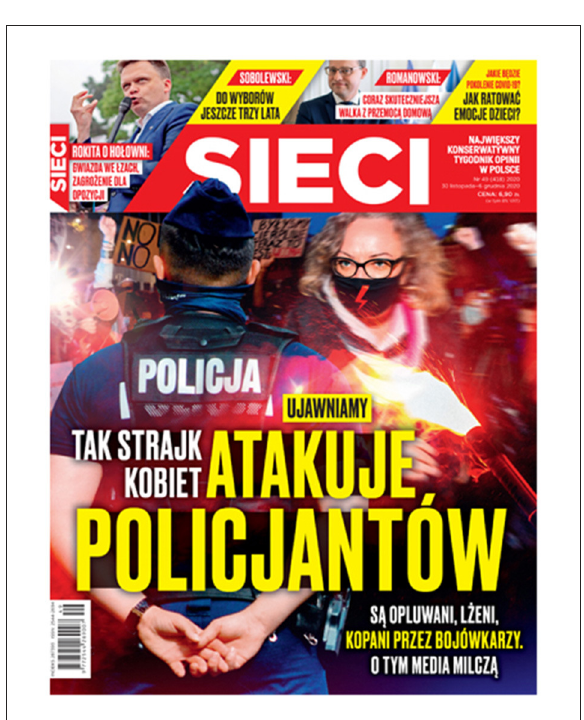
FIGURE4 The cover of Sieci , no. 49/2020 of 30 November